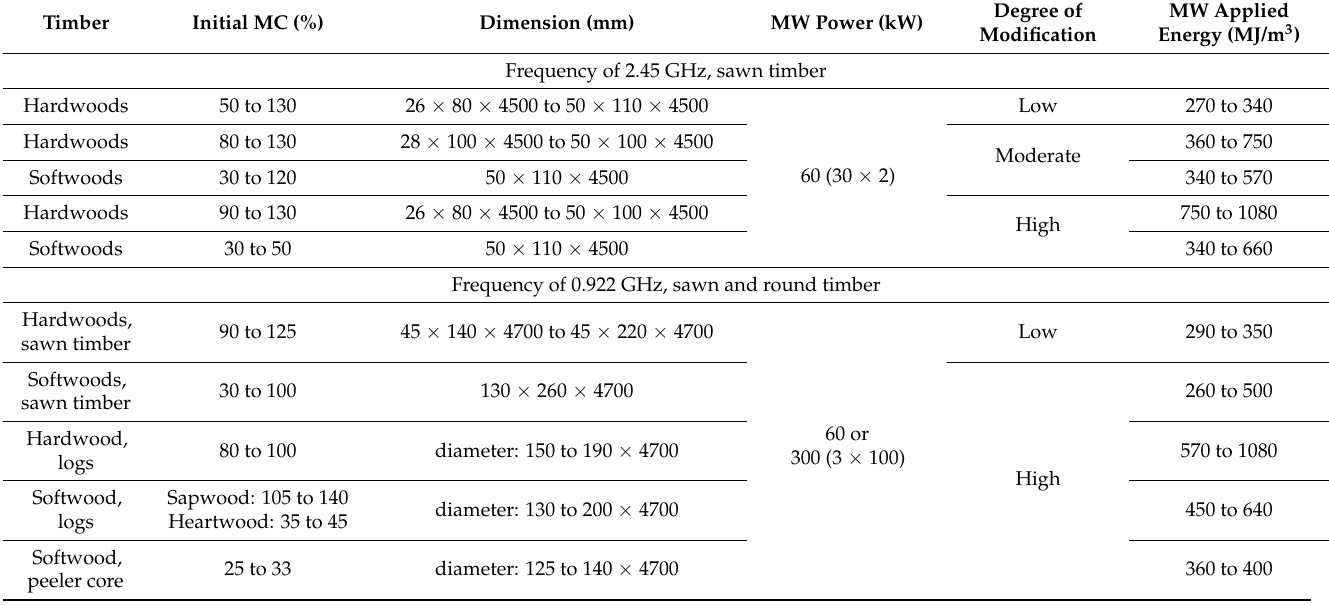
Table 5. MW equipment specifications and wood samples information used by